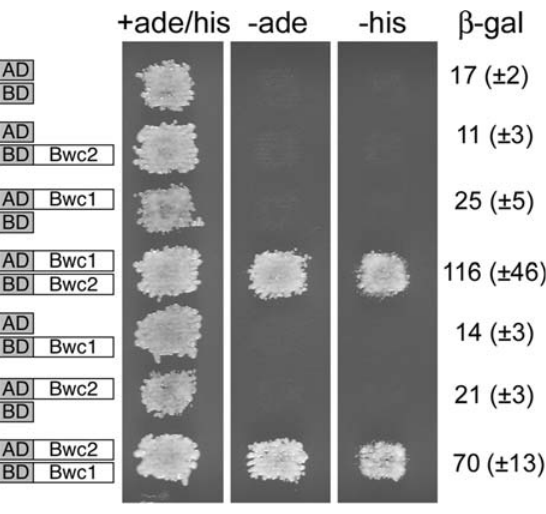
Figure 6. Bwc1 and Bwc2 Physically Interact The coding regions of the BWC1 and BWC2 genes were fused adjacent to the AD or BD of S. cerevisiae GAL4 . Plasmids were cotransformed into a S. cerevisiae strain in which Gal4 regulates the ADE2, HIS3, and lacZ genes. Growth of strains in the absence of adenine ( (cid:1) ade)